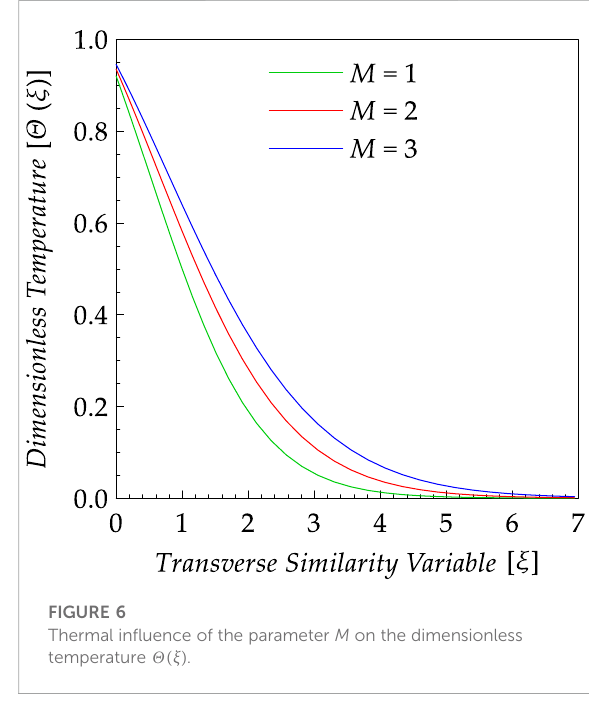
FIGURE 6 Thermal in fl uence of the parameter M on the dimensionless temperature Θ ( ξ ) .